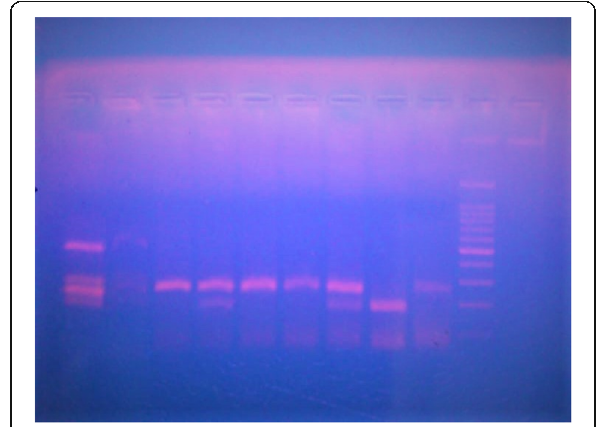
Fig. 1 Vitamin D receptor gene polymorphism (Fok 1). Lanes 1, 3, 4, and 7: homozygous wild FF genotype (265 bp). Lanes 2 and 5: heterozygous genotype Ff (265 bp, 196 bp, and 69 bp). Lane 6: homozygous mutant ff genotype (196 bp and 69 bp). Lane 8: 100bp DNA Ladder (100, 200, 300, 400, 500,600,700,800, 900, 1000, 1500 bp)